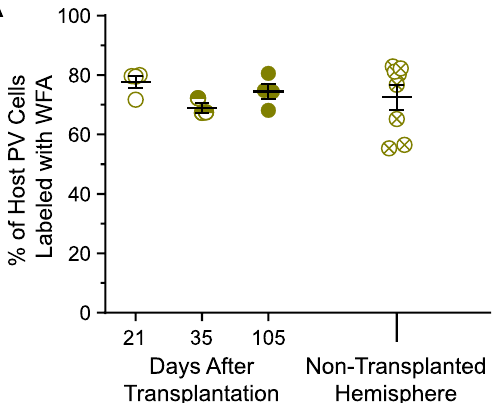
Figure 3. Transplantation does not disturb PNNs on host PV inhibitory neurons. ( A ) Host PV cells co- labeled with WFA was unaffected by transplantation and similar to the non-transplanted hemisphere (N- TH) (21 DAT = 77.7 ± 2.00 (open), 35 DAT = 68.97 ± 1.64 (half-filled), 105 DAT = 74.5 ± 2.54 (filled), N-TH = 72.54 ± 4.14 (crossed)). n 21DAT = 1,203 host PV cells, 7 sections, 4 mice; n 35DAT = 845 host PV cells, 7 sections, 3 mice;